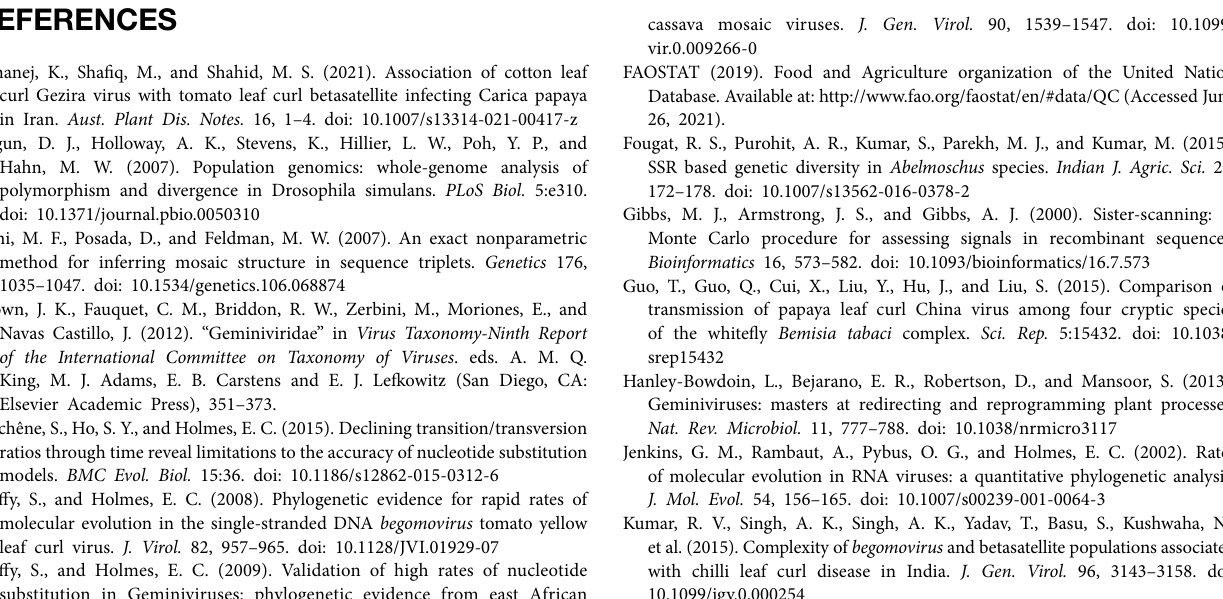
Supplementary Figure S1 | Maximum clade credibility phylogenetic tree associated with papaya leaf curl disease begomoviruses in India aligned using BEAST software v.1.10’s FigTree program. Tree is formed using the relax.tree file, which is automatically rooted by the use of a relaxed molecular clock. Supplementary Figure S2 | Graphical representation of a temporal signal generated by the BEAST software; Estimated rates of nucleotide substitution from actual date of isolation for begomoviruses, ORFs, and betasatellites associated with PaLCD (eight datasets) with 95% HPD values, are shown in dark grey. The reshuffled mean estimated rates for eight datasets with 95% HPD values are shown in light